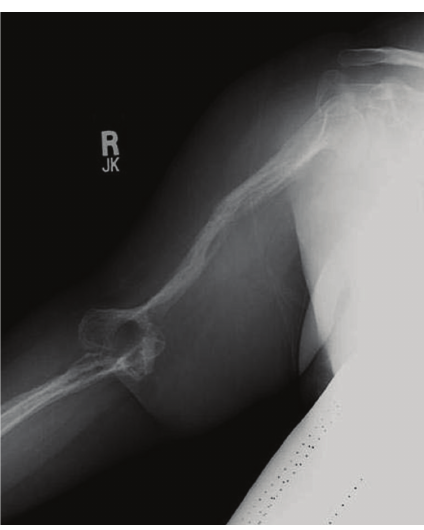
Figure 1: Plain radiographs of the upper extremity taken 8 years earlier revealed a destructive lytic process involving the humerus, radius, and ulna with pathologic midshaft humerus fracture and chronic dislocation of the humeroulnar